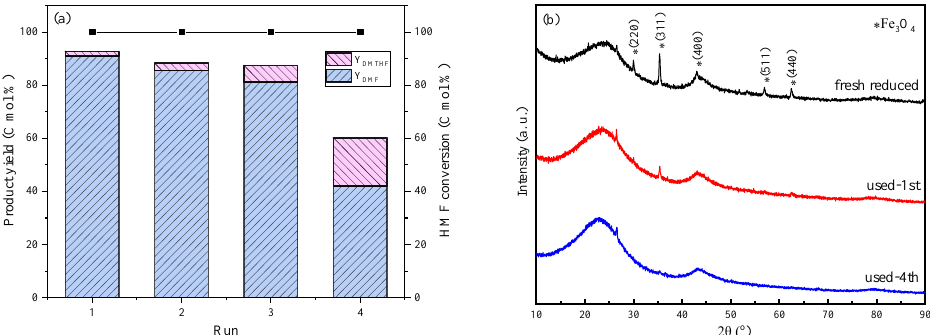
Figure 8. ( a ) Stability of 0.5% Pt-2% FeO x /AC catalyst. Reaction conditions: T = 180 °C, p (H 2 ) = 1.5 MPa, t = 6 h, stirring speed = 600 rpm, m HMF = 250 mg, m catalyst = 100 mg, V n-butanol = 20 mL. ( b ) The XRD patterns of freshly-reduced, first-use and fourth-use 0.5% Pt-2% FeO x /AC catalyst.